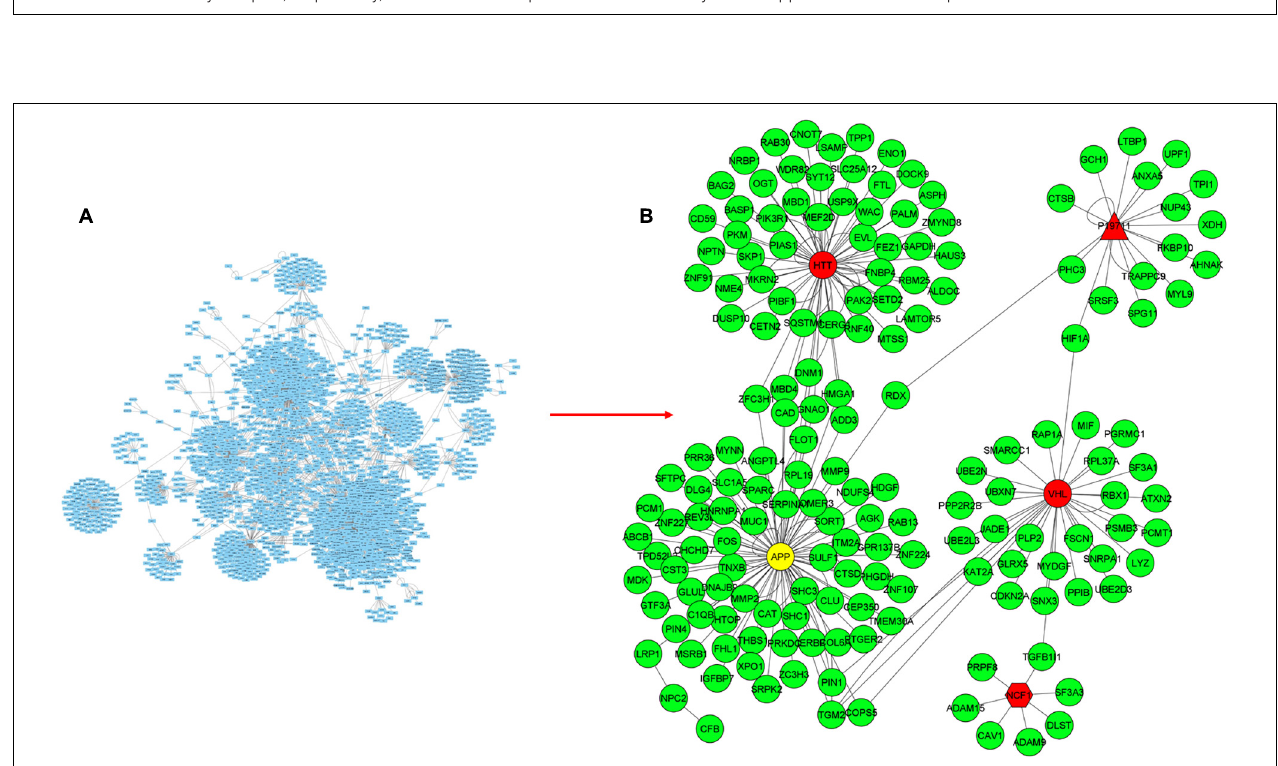
FIGURE 4 | Mapping transcriptome data to CD-specific PPI network for the discovery of subnetworks with KPM. (A) PPI network for CD obtained from the PSICQUIC database, including 2777 proteins and 3475 interactions. (B) Mapping transcriptome data to CD-specific PPI network reveals a module containing 175 proteins and 217 interactions. Green and red colored nodes correspond to the DEGs in the expression datasets and the genes that are not significantly different from the healthy samples, respectively. Genes depicted in yellow are DEGs in only one of the datasets. Circle-shaped nodes were mapped to both of the expression datasets, nodes with pentagon shape were mapped to only one of the datasets, and triangle nodes were not mapped to any of the datasets.